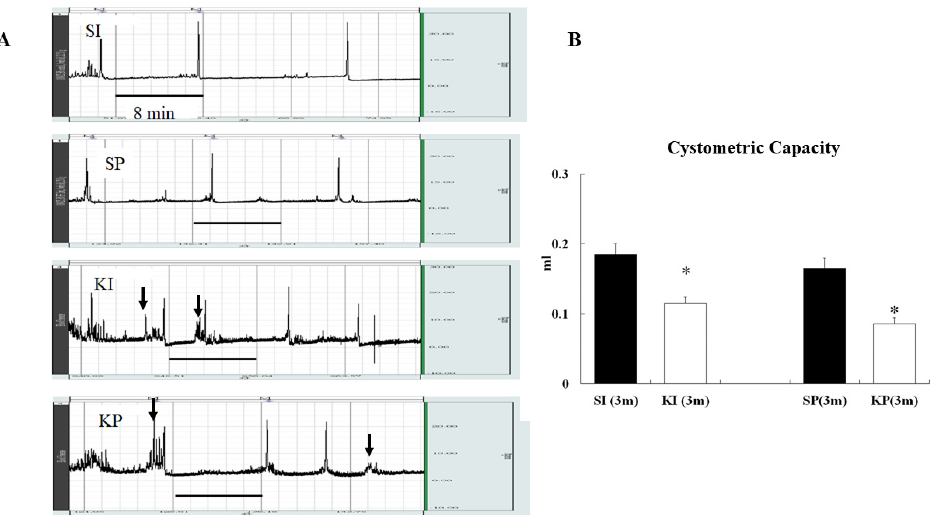
Figure 5. Ketamine inhalation and urodynamic changes. Unstable detrusor contractions (black arrows) were recorded in the cystometry curves of KI and KP mice but not in SI and SP mice ( A ). At 3 months, KI and KP mice had significantly lower bladder capacity than SI and SP mice ( p < 0.05) ( B ). The values are expressed in means ± SD. An asterisk indicates a significant difference in Bonferroni post-tests following t -test ( p < 0.05).